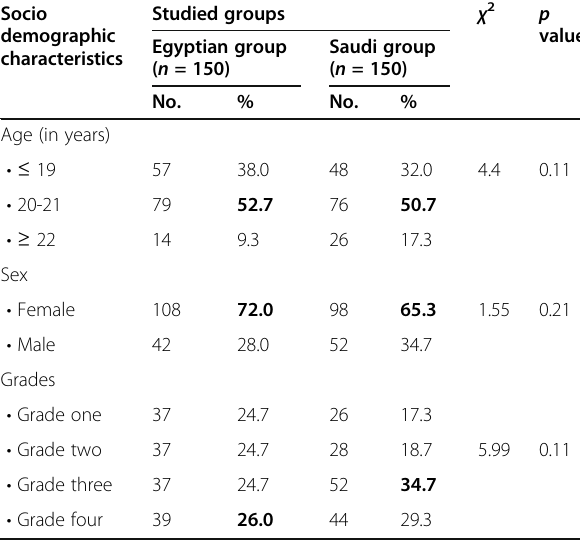
Table 1 Comparison between Egyptian and Saudi nursing students as regards socio demographic characteristics (each group n = 150) Socio demographic